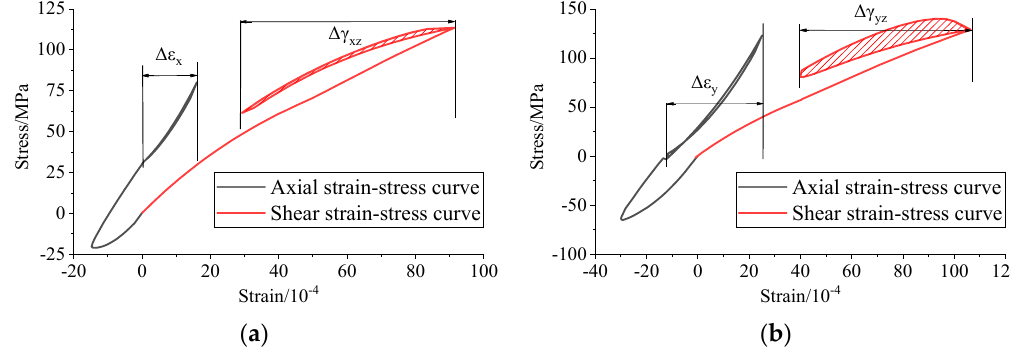
Figure 19. Stress–strain curve at the risk point of the slave model. ( a ) Leading edge; ( b ) Trailing edge.